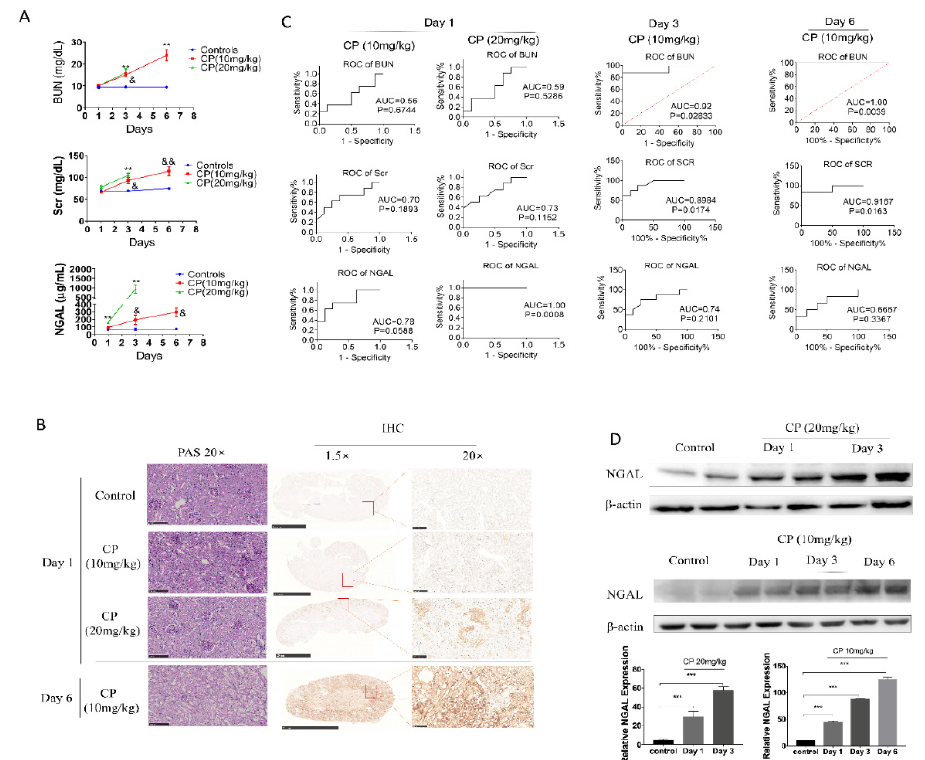
Figure 2. Serum Neutrophil Gelatinase-associated Lipocalin (NGAL) has a superior predictive capability for early kidney injury compared to blood urea nitrogen (BUN) and serum creatinine (Scr) in cisplatin-induced AKI but is not superior at later phases. ( A ) Concentrations of sNGAL, BUN, and Scr in AKI animals at 1, 3, and 6 days after cisplatin injection. ( B ) Representative pictures of Periodic acid-Schi ff (PAS) staining and NGAL immunohistochemistry in kidney tissues. ( C ) receiver operating characteristic (ROC) curve comparison of sNGAL, BUN, and Scr to predict AKI at day 1, day 3, and day 6. ( D ) NGAL protein levels increased in kidney tissues in a dose-dependent and time-dependent manner according western blot. CP refers to cisplatin; *, p < 0.05, **, p < 0.01, ***, p < 0.001, 20 mg / kg CP group vs. control; & , p < 0.05; && , p < 0.01; 10 mg / kg CP group vs. control ( n = 8 for each